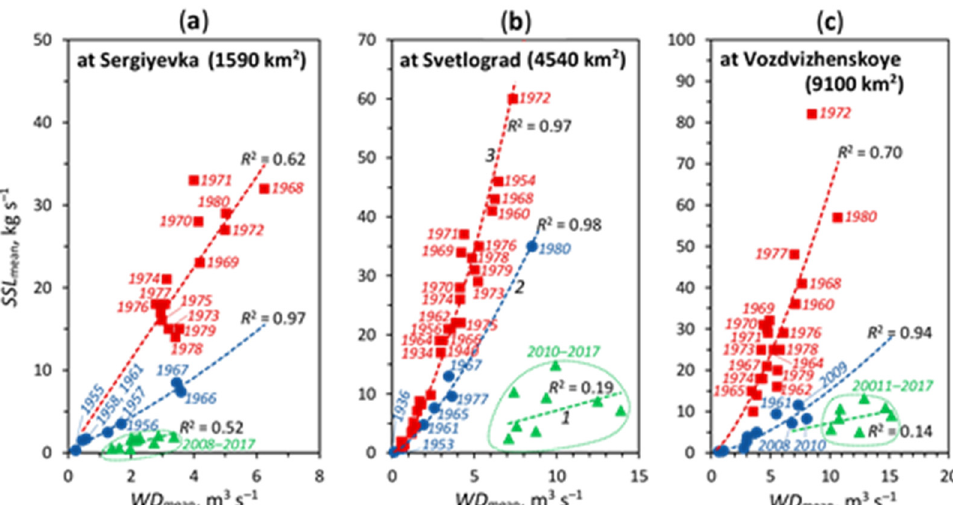
Figure 7. The ratio between mean annual water discharge ( WD mean ) and mean annual suspended sediment load ( SSL mean ) of the Kalaus River at the analyzed hydrological stations ( a – c )(see Figure 1; Table 1) from the 1930s to 2017. The scenarios for: ( 1 ) green markers (green power trend lines)—the years of relatively weak sediment formation in the river’s basin upriver of the corresponding station; ( 2 ) blue markers (blue power trend lines)—the years of relatively moderate sediment formation; ( 3 ) red markers (red power trend lines)—the years of relatively enhanced sediment formation. R 2 —the coefficient of approximation for the power trend lines; 1970 , 1971 , 1972 , etc.—the years of observations for WD mean / SSL mean .